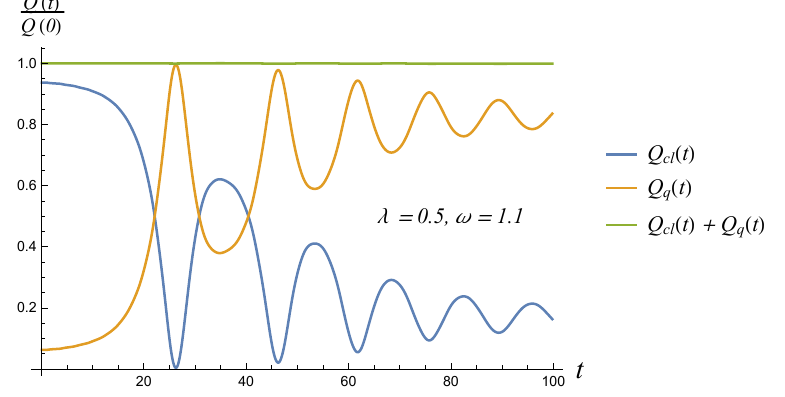
Figure 4 . Behaviour of the classical and quantum charge for long time. Conservation of charge is showed. Here ! = 1 : 1, (cid:21) = 0 :